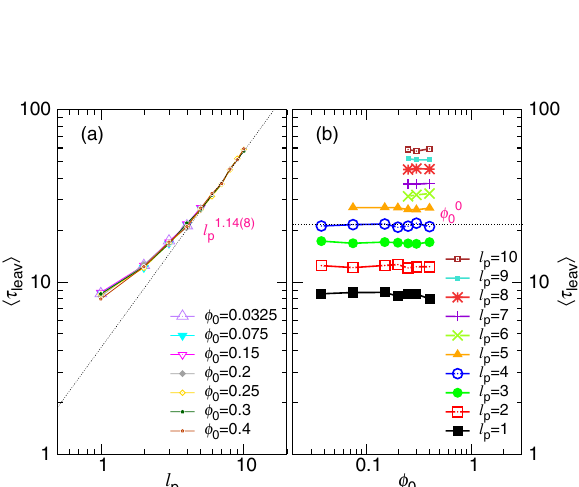
τ leav as a function of ℓ p at various φ 0 values, indicated in the legend. ( b ) (cid:31) (cid:30)